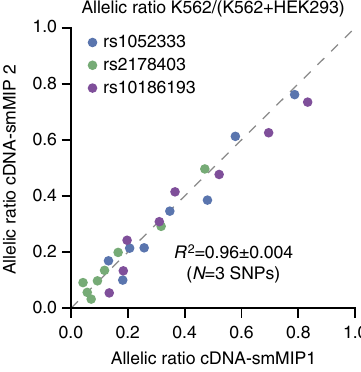
Figure 5 | Estimation of allelic ratios with cDNA-smMIPs. Concordance of allelic ratios estimated from distinct smMIPs (respectively non-overlapping extension probes and non-overlapping ligation probes) targeting the same SNP in a serial dilution of cDNA from K562 cell line with cDNA from HEK293 cell line (8 dilution steps). For all SNPs, the two cell lines are homozygous for the opposite allele. Reported variation in R 2 is s.d.